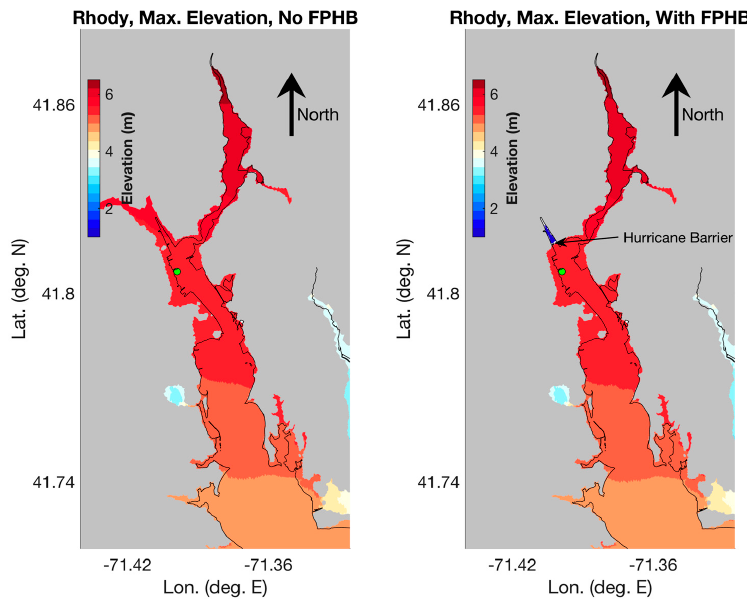
Figure 9. Time series of model water surface elevation during Hurricane Rhody at Providence and Newport. The model grid does not include the FPHB in this case, and river inflows are not simulated.